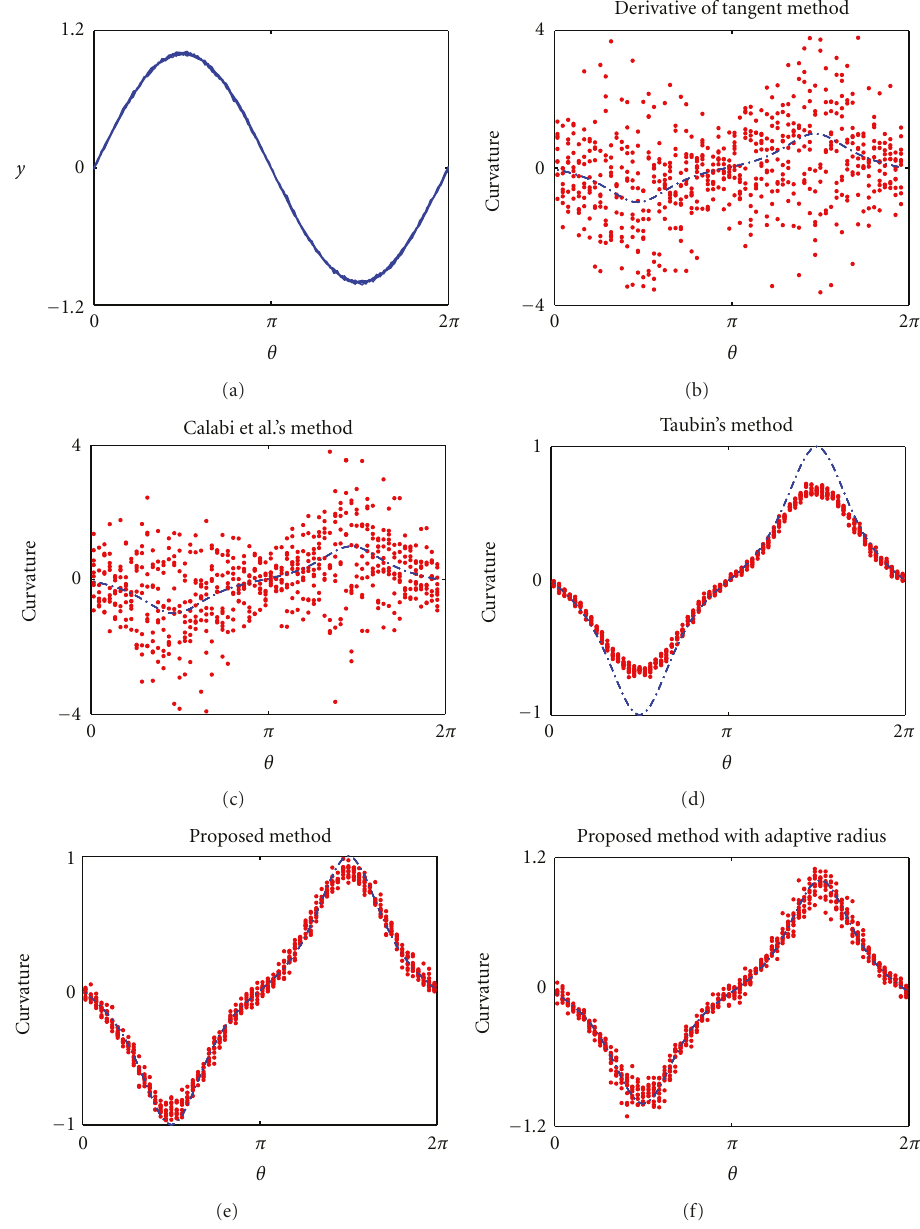
Figure 7: Trial-to-trial variability in curvature estimates. The data consist of 10 trials. (a) sinusoidal waveforms with additive Gaussian noise, (b) curvature estimate obtained by derivative of tangent, (c) curvature estimate obtained by Calabi et al.’s algorithm, (d) curvature estimate obtained by Taubin’s algorithm, (e) curvature estimate obtained by line integrals, and (f) curvature estimate obtained by line integrals with adaptive radius. Notice that these figures have di ff erent ranges in vertical coordinate because some methods yield noisy results. The true curvature is denoted by a dashed blue